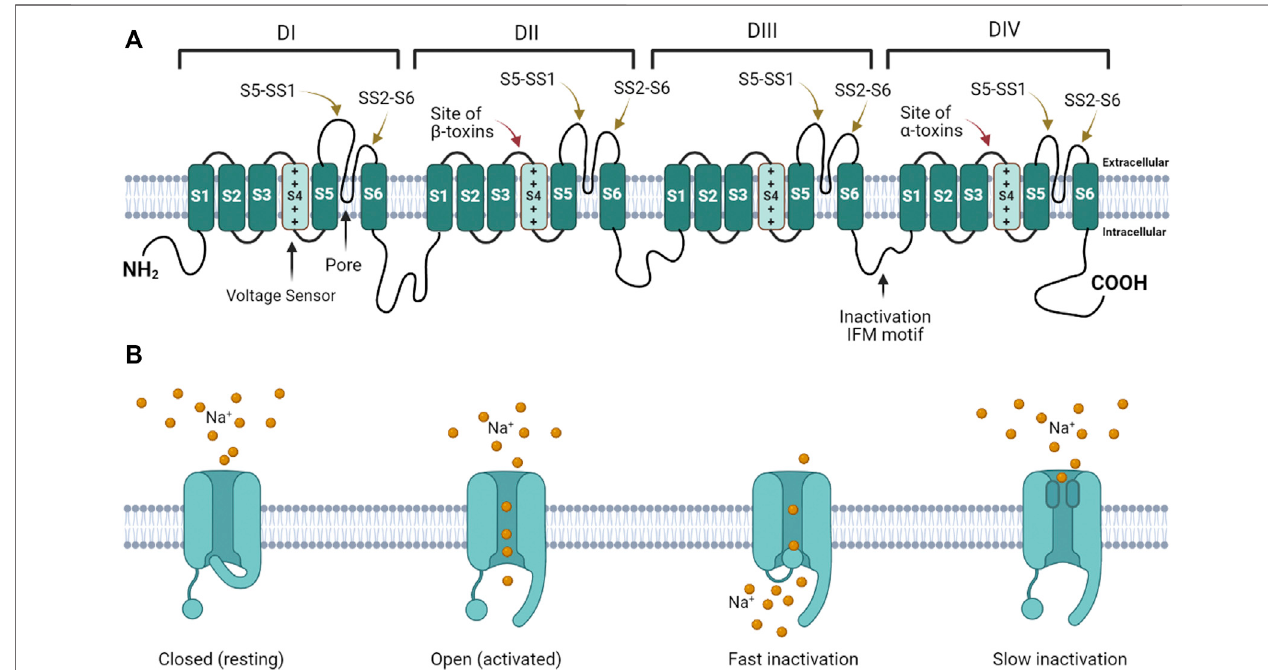
FIGURE 1 | Voltage gated sodium channel structure and function. (A) The channel consists of four homologous domains (DI – DIV). Each domain consists of six transmembrane helices (S1 – S6). The fourth helix (S4) in each domain contains basic amino acids that act as voltage-sensor gating charges. The re-entrant loops betweenS5andS6ineachdomainformthepore(blackarrowpointstoporeinDI).TheextracellularloopsconnectingS5tothepore(S5 – SS1)andtheporetoS6(SS2 – S6) form the mouth of the pore. The intracellular loop connecting DIII to DIV forms the fast inactivation hinged lid. The isoleucine-phenylalanine-methionine (IFM) motifiscriticalforfastinactivationgating.TheDIIandDIVS3 – S4linkersformtheprimaryscorpion β and α toxinbindingsites,respectively. (B) Whenthechannelisinthe resting state, the activation gate is closed. When the channel is activated, the gate opens. During activation the inactivation gate (hinged lid) is disengaged. During fast inactivation, thehinged lidoccludes theintracellular sideofthepore.Whenthechanneltransitionsintotheslow inactivated state,thepore loopschangeconformationto obstruct the